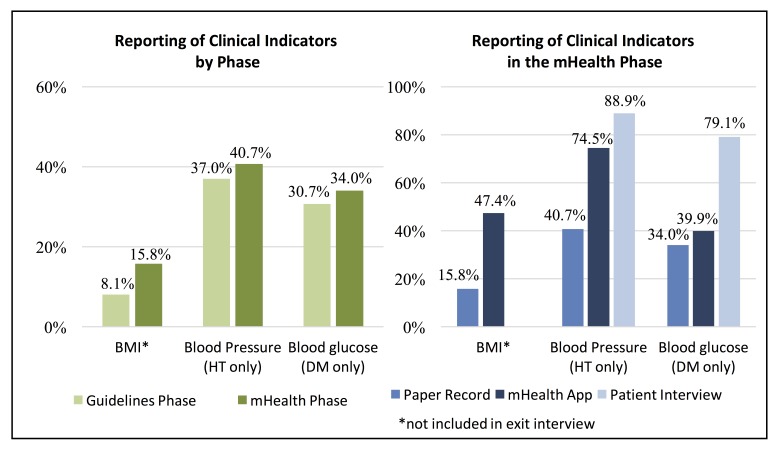
Figure 2. Reporting of Clinical Indicators by Phase and Information Source in the mHealth Phase